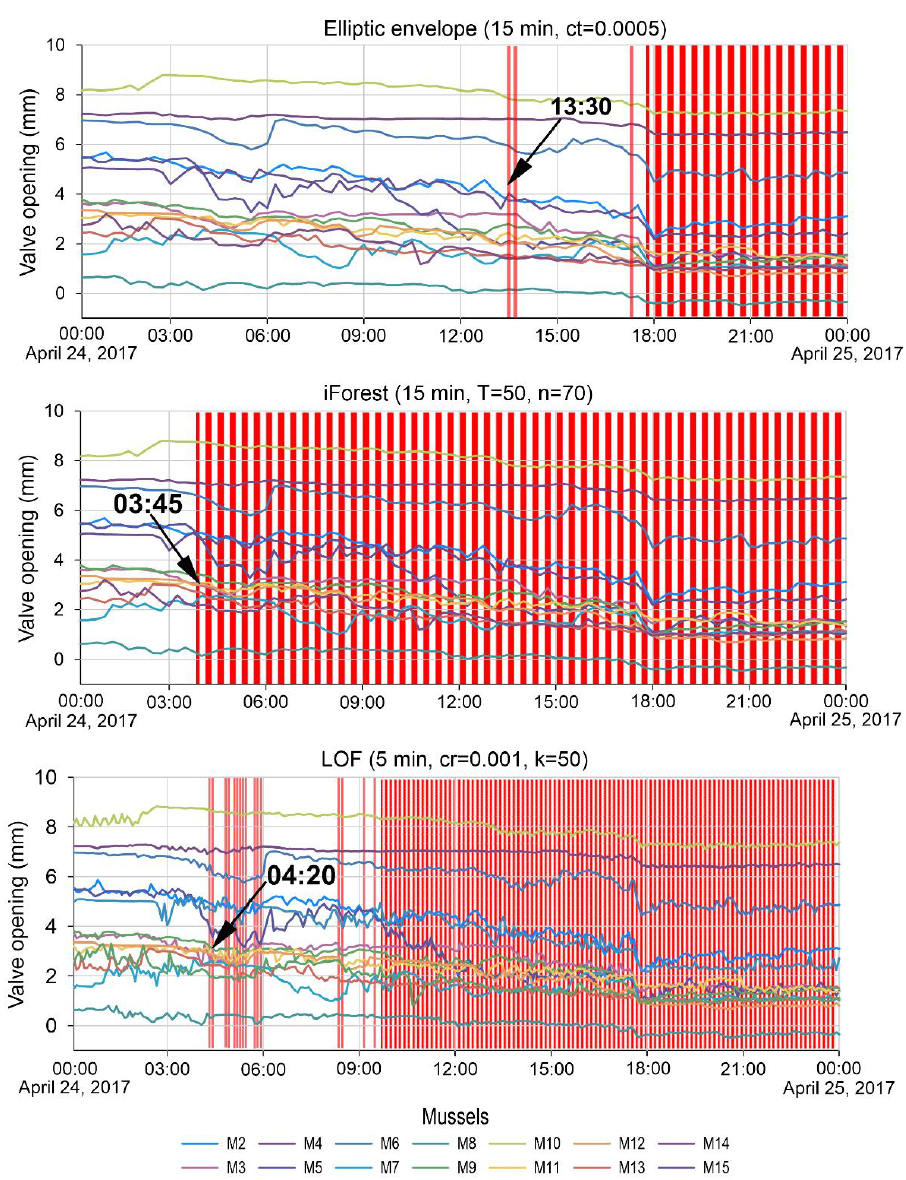
Figure 9. Detection time of the second anomaly by different algorithms.